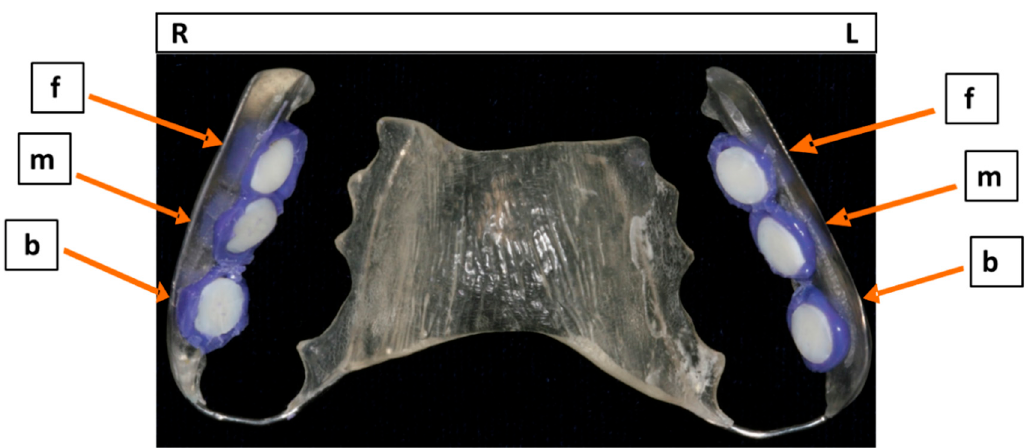
Figure 1. Upper jaw acrylic appliance with six bovine enamels slabs (BES) fixed with silicone to individually designed slots situated on both sides, right (R) and left (L) of the appliance. The enamel surfaces of the BES were placed in different locations at the front (f), in the middle (m) and at the back (b) of the appliance.